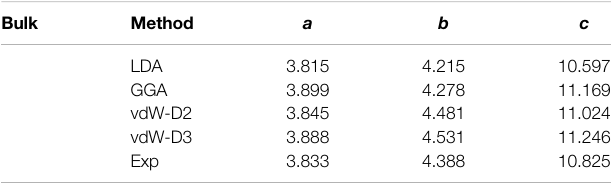
TABLE 2 | The Raman vibration frequency (in the unit of cm − 1 ) of bulk GeSe with different